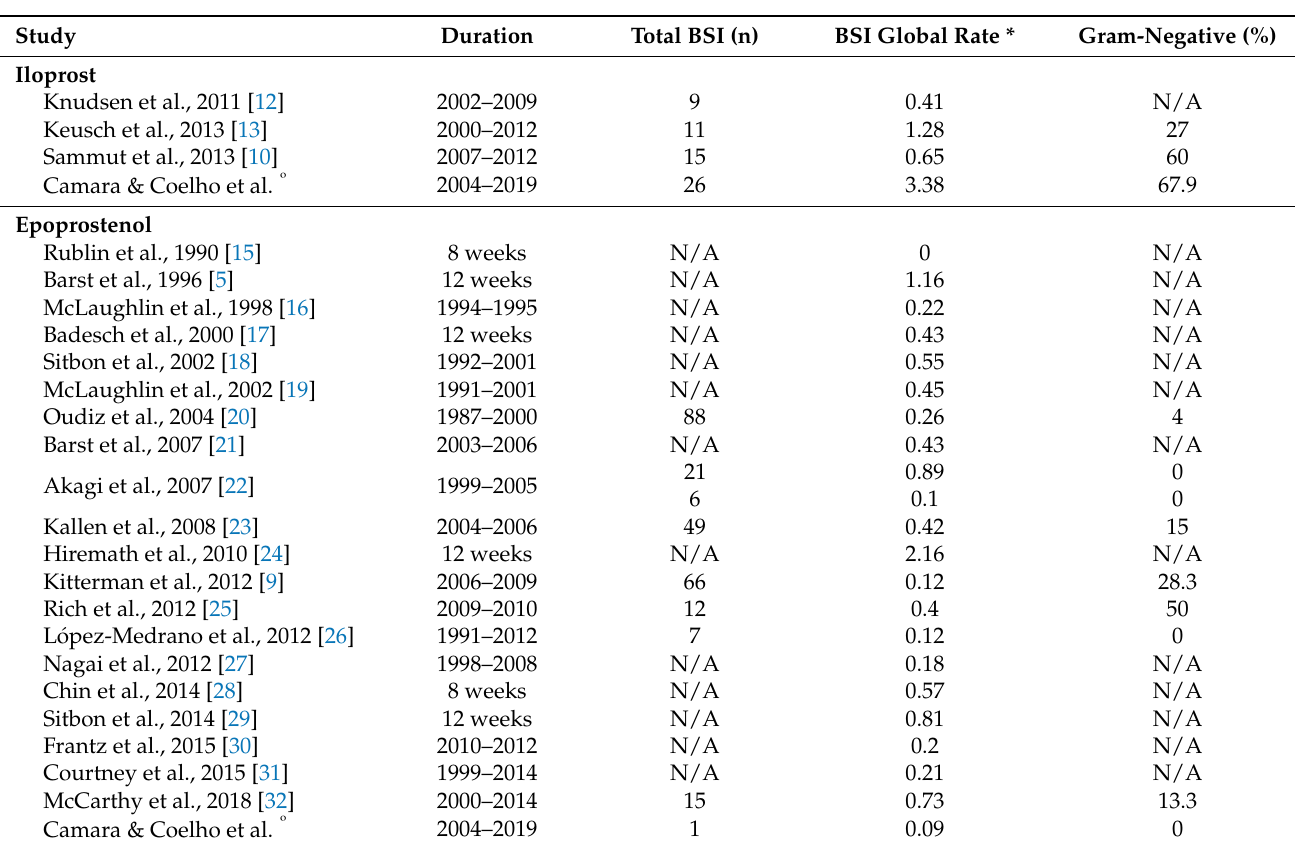
Table 6. Summary of BSI rate in patients under iPCAs (adapted from Sammut et al. [10] and Boucly et al.